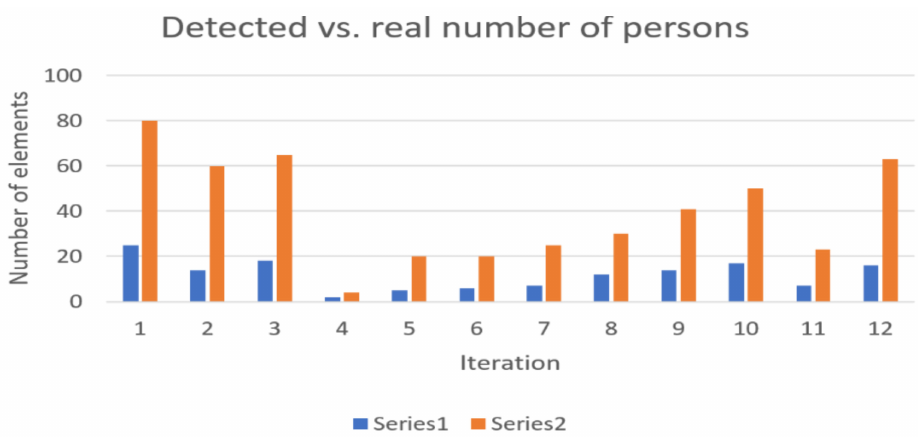
Figure 4. Detected devices (represented in blue—Series 1) versus real number of persons (represented in orange—Series 2) present on platforms—no trains in station (Subway Station 2 subway